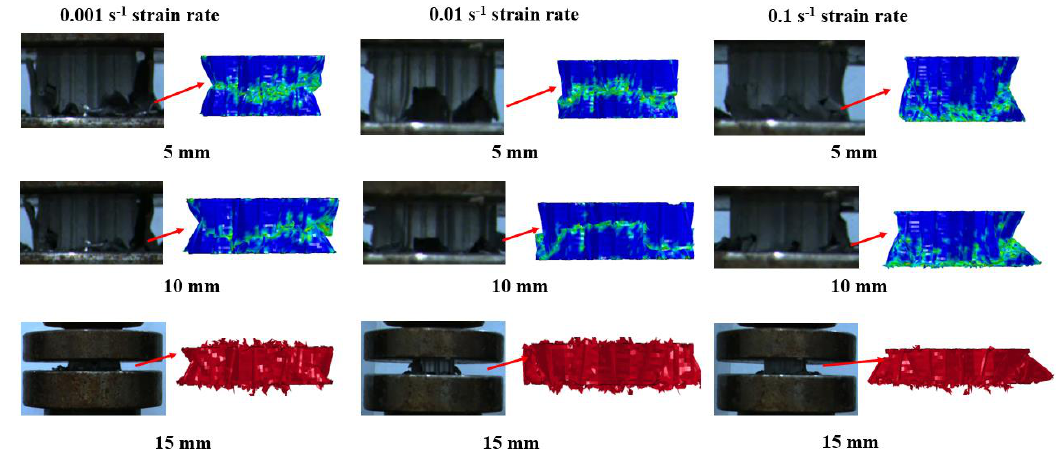
Figure 8. The crushing process of BHTS – I under various strain rate loading.